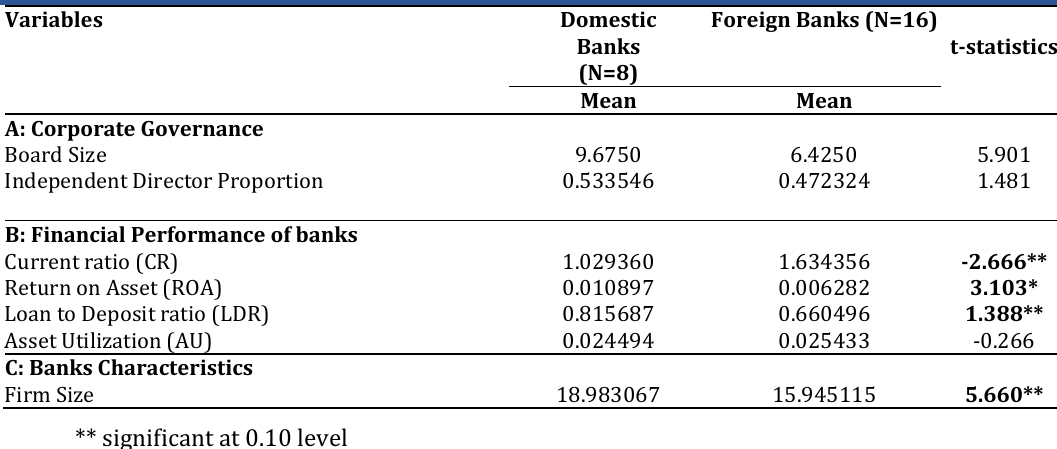
Table 5: Differences of Means